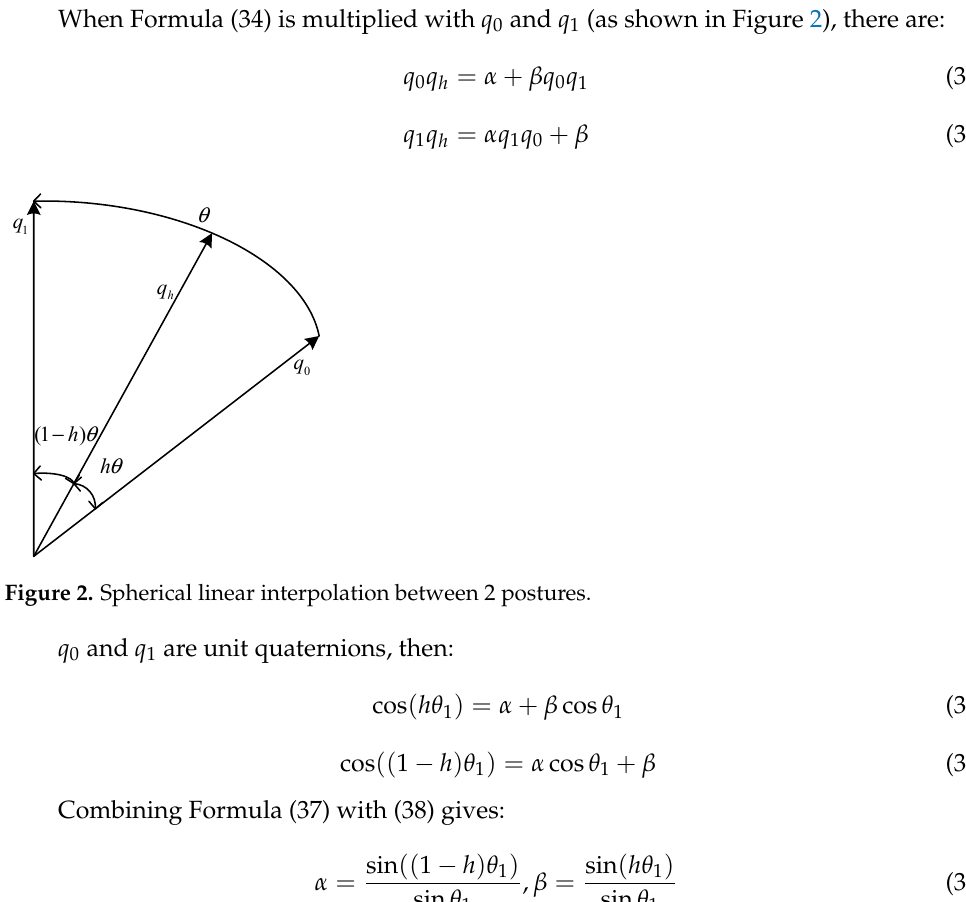
In addition, Slerp could be expressed as: